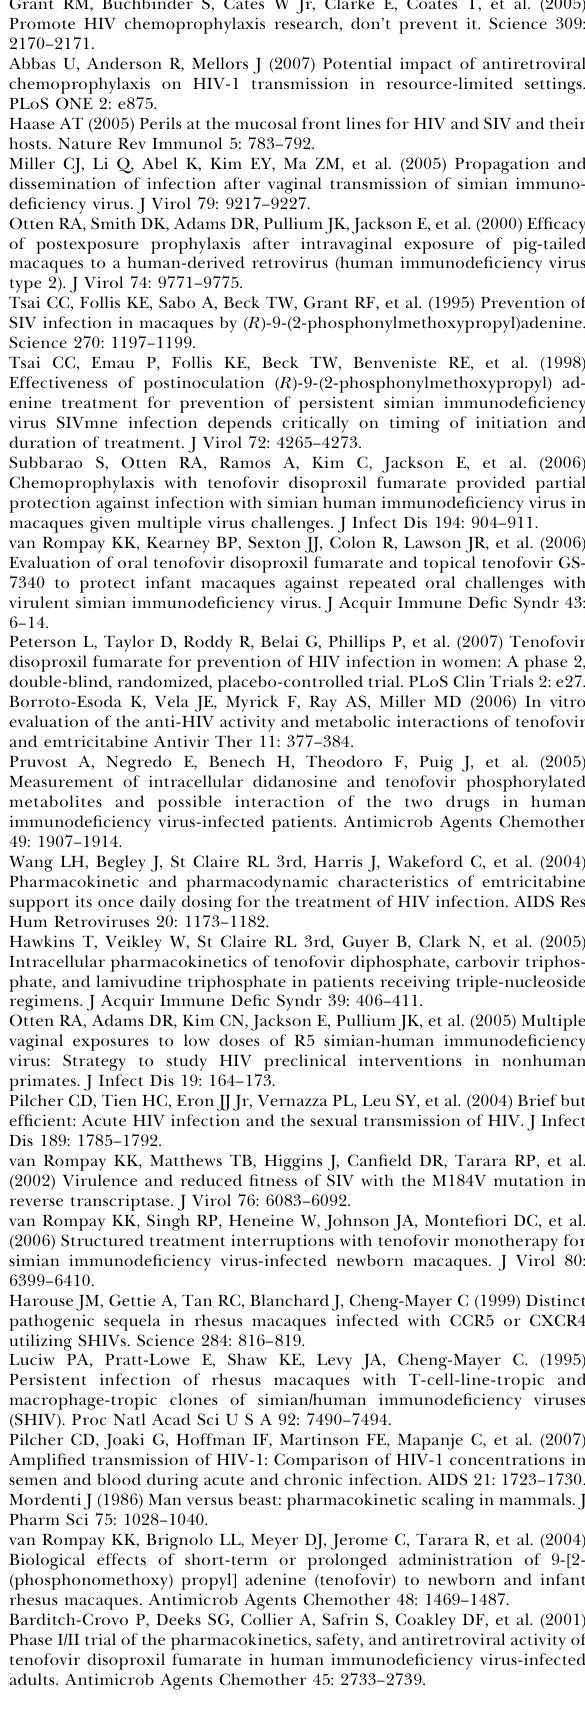
Table S1. Macaques, Interventions, and Outcome of the Challenge